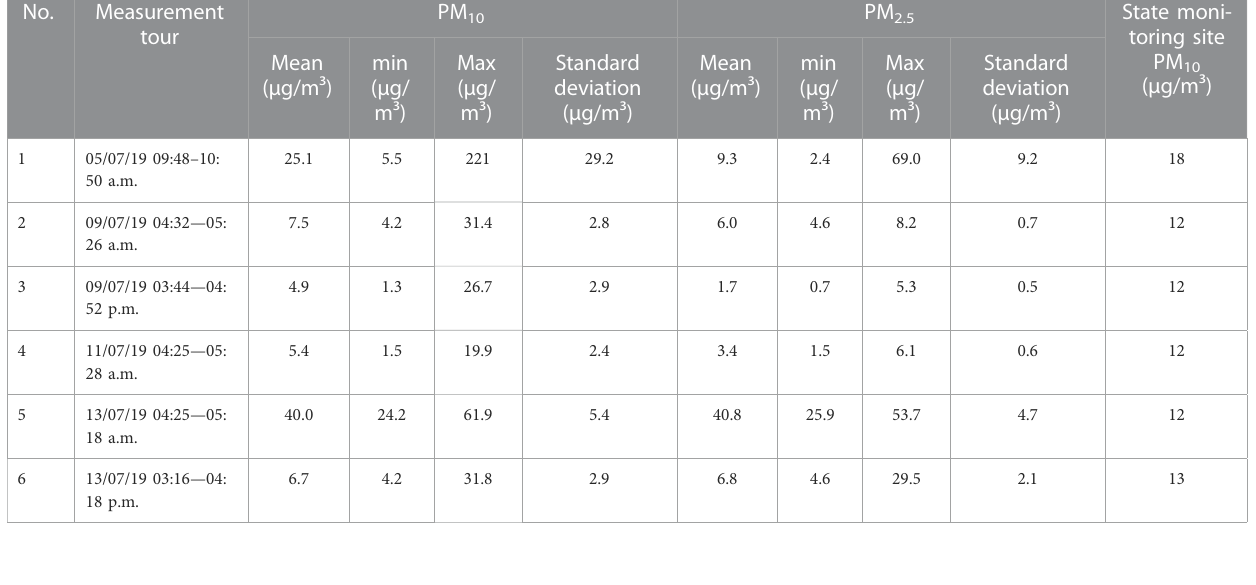
TABLE 1 summary statistics for PM 2.5 and PM 10 records of bike tours. No.